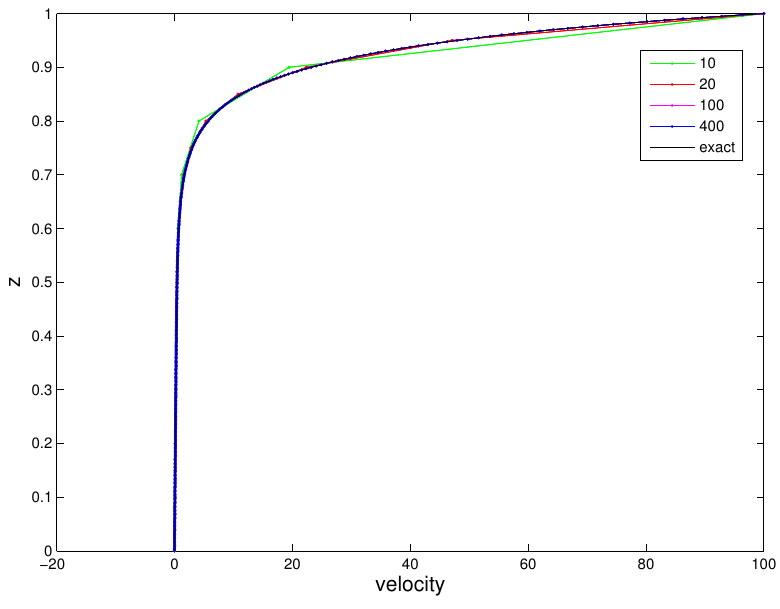
Figure 5. Velocities of the periciliary layer (PCL) fluid and the exact solution when the angle θ is perpendicular to the horizontal plane. Table 1. l 2 -norm errors of the PCL velocity at the angle θ = 90 ◦ along the z -axis with fixed boundary